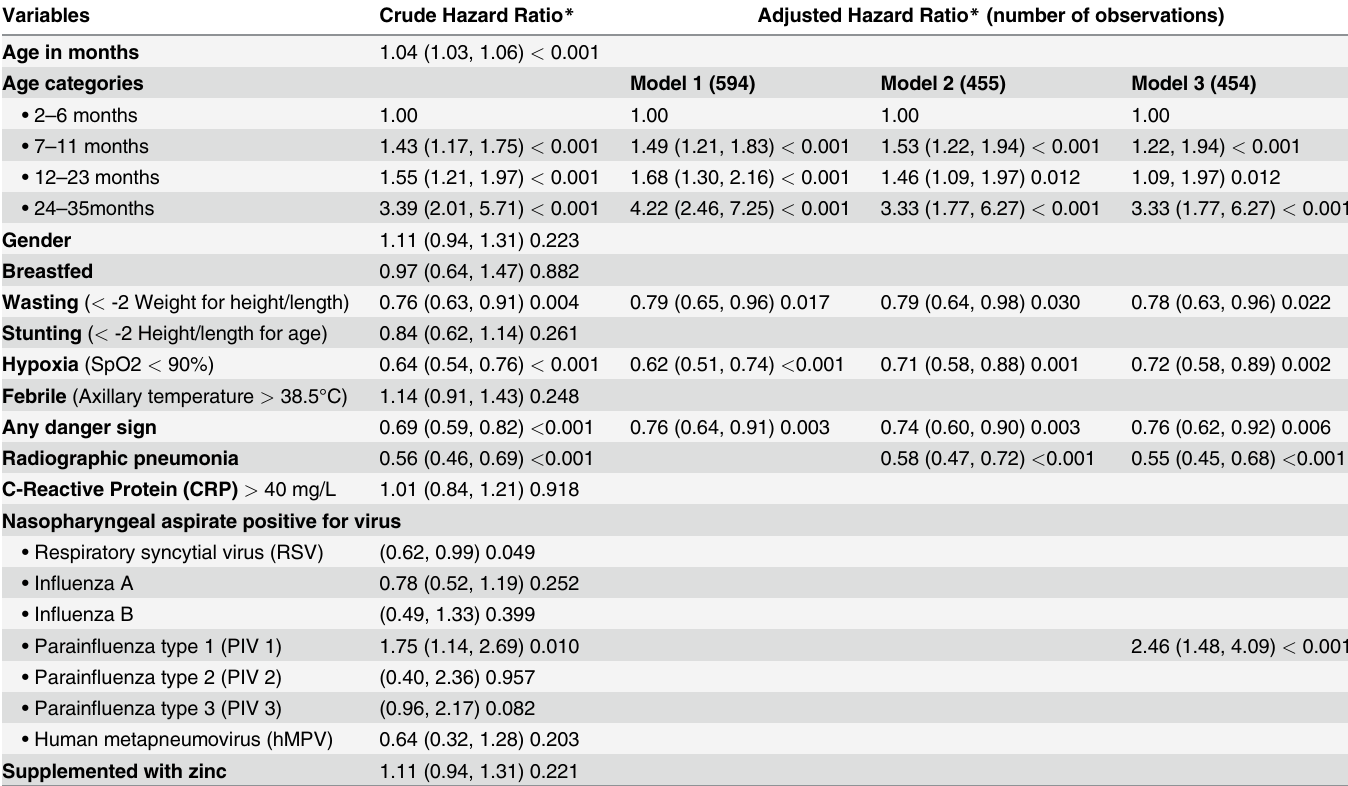
Table 2. Predictors of Time till Recovery of illness episode in children 2 – 35 months hospitalized with WHO defined Severe